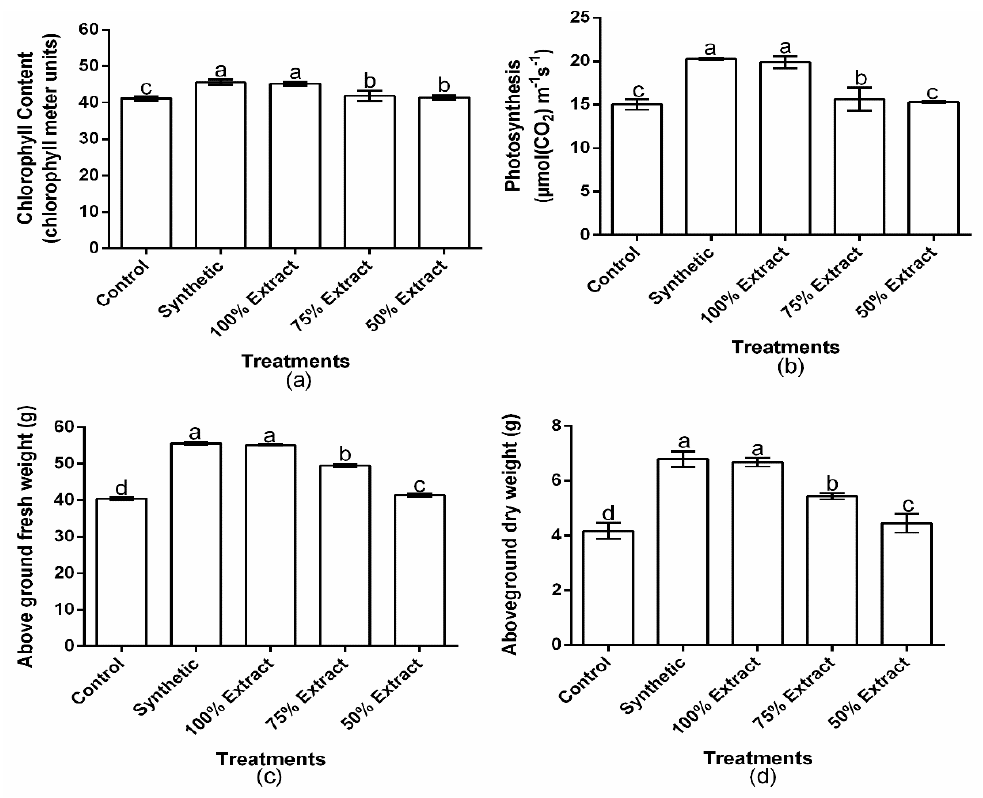
Figure 6. Effect of potato leaf extract on ( a ) chlorophyll content, ( b ) photosynthesis, ( c ) aboveground fresh weight, and ( d ) aboveground dry weight. Data represent the mean ± standard deviation of three replicates. Lowercase letters indicate means that are significantly different according to the LSD test ( p < 0.05). Note: synthetic pesticide (recommended rate of Beta cypermethrin).